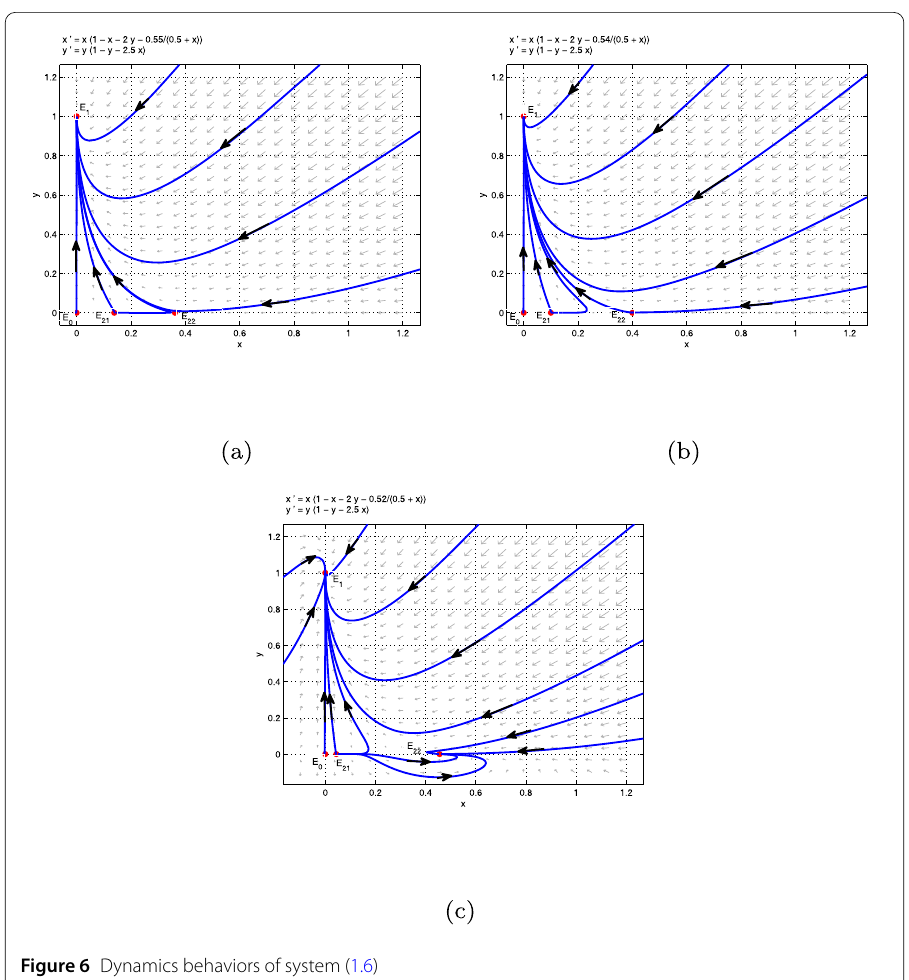
Figure 6 Dynamics behaviors of system